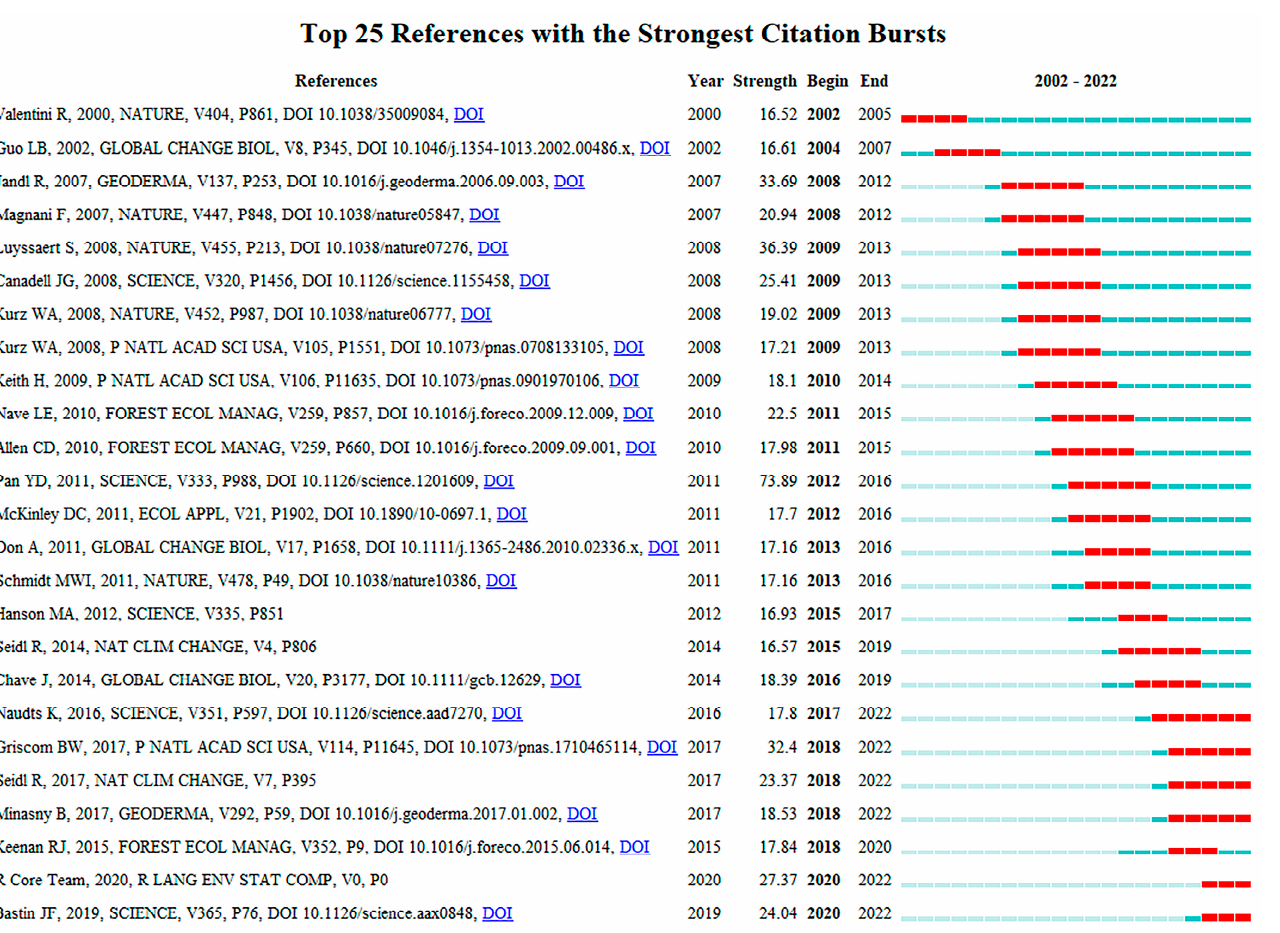
Figure 14. The top 25 pieces of literature with the highest strength values in the literature co-citation analysis. The literature included in the figure are (from top to bottom). (1) Respiration as the main determinant of carbon balance in European forests. (2) Soil carbon stocks and land use change: a meta analysis. (3) How strongly can forest management influence soil carbon sequestration? (4) The human footprint in the carbon cycle of temperate and boreal forests. (5) Old-growth forests as global carbon sinks. (6) Managing Forests for Climate Change Mitigation. (7) Mountain pine beetle and forest carbon feedback to climate change. (8) Risk of natural disturbances makes future contribution of Canada’s forests to the global carbon cycle highly uncertain. (9) Re-evaluation of forest biomass carbon stocks and lessons from the world’s most carbon-dense forests. (10) Harvest impacts on soil carbon storage in temperate forests. (11) A global overview of drought and heat-induced tree mortality reveals emerging climate change risks for forests. (12) A Large and Persistent Carbon Sink in the World’s Forests. (13) A synthesis of current knowledge on forests and carbon storage in the United States. (14) Impact of tropical land-use change on soil organic carbon stocks – a meta-analysis. (15) Persistence of soil organic matter as an ecosystem property. (16) Crystal Structure of a Lipid G Protein–Coupled Receptor. (17) Increasing forest disturbances in Europe and their impact on carbon storage. (18) Improved allometric models to estimate the aboveground biomass of tropical trees. (19) Europe’s forest management did not mitigate climate warming. (20) Natural climate solutions. (21) Forest disturbances under climate change. (22) Soil carbon 4 per mille. (23) Dynamics of global forest area: Results from the FAO Global Forest Resources Assessment 2015. (24) R Core Team (2020). (25) The global tree restoration potential.